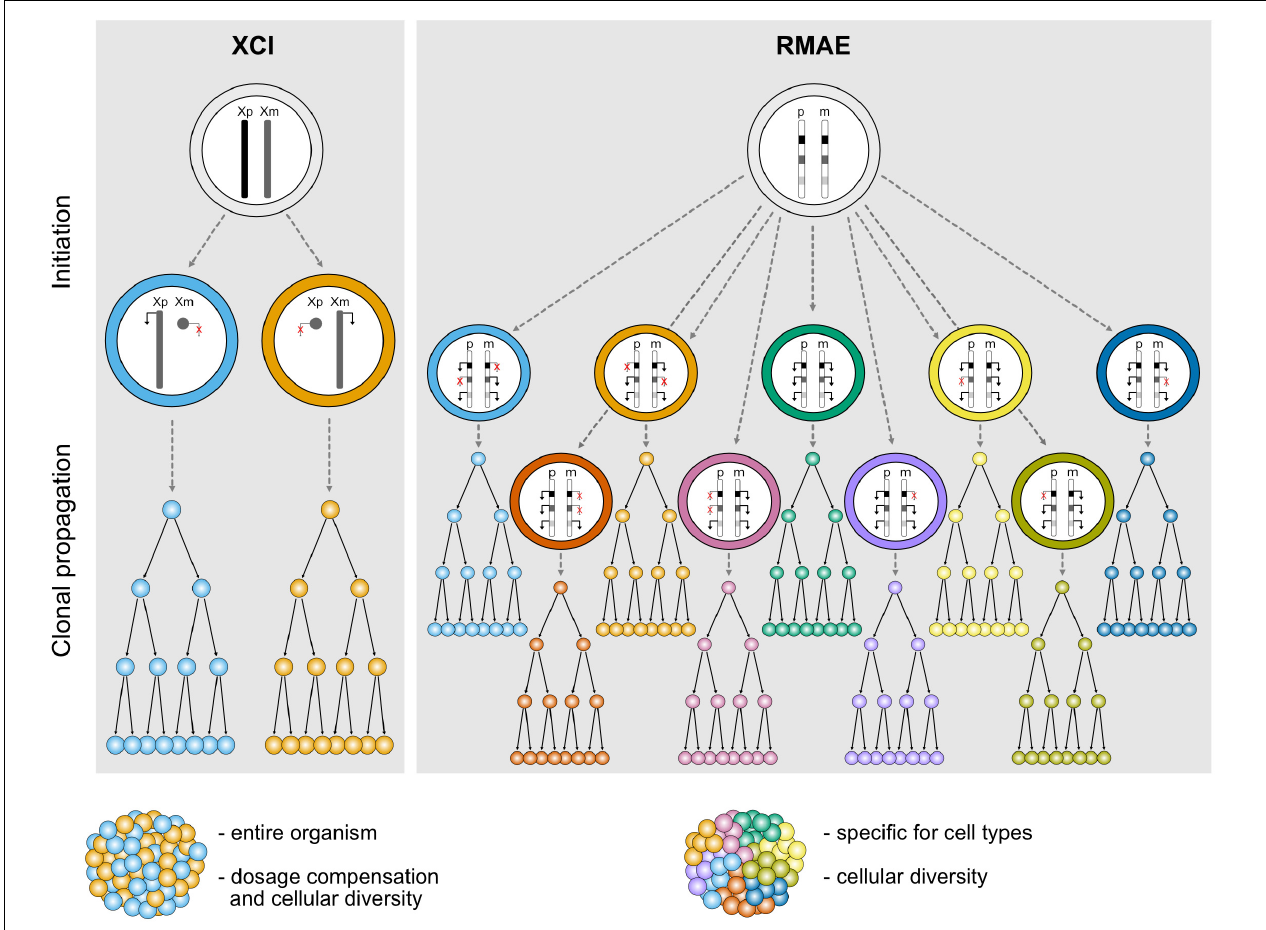
FIGURE 1 | Schematic representation illustrating the features of different types of random monoallelic expression: X-chromosome inactivation (XCI) and random monoallelic autosomal expression (RMAE). Xp, X chromosome of paternal origin, Xm, X chromosome of maternal origin; p, paternal autosome, m, maternal